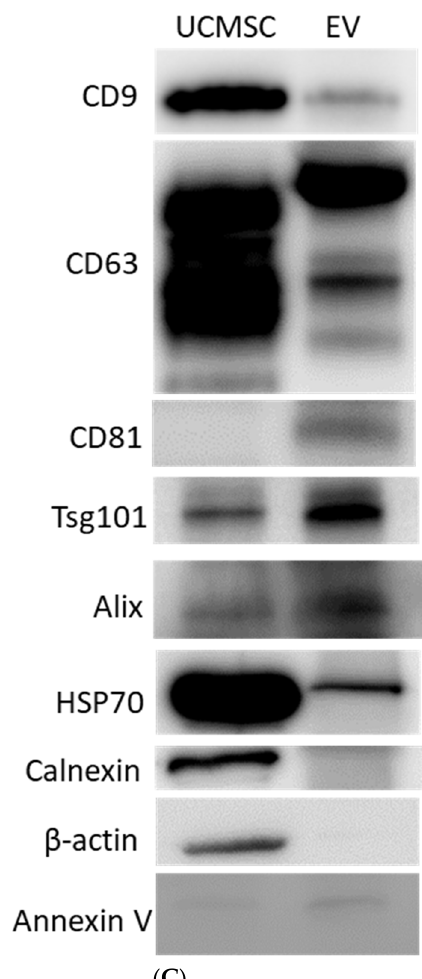
Figure 1. Characteristics of UCMSC-EVs. ( A ) Size distributions of UCMSC-EVs based on NTA measurements. The mean diameters were 103.3 ± 1.0 nm. ( B ) EVs were negatively stained and viewed by transmission electron microscopy at a magnification of 60,000. The scale bar represents 200 nm. ( C ) Representative immunoblot showing the expression of the EVs’ markers CD9, CD63, CD81, Tsg101 and Alix, whereas HSP70, calnexin, annexin V and β -actin acted as negative control.